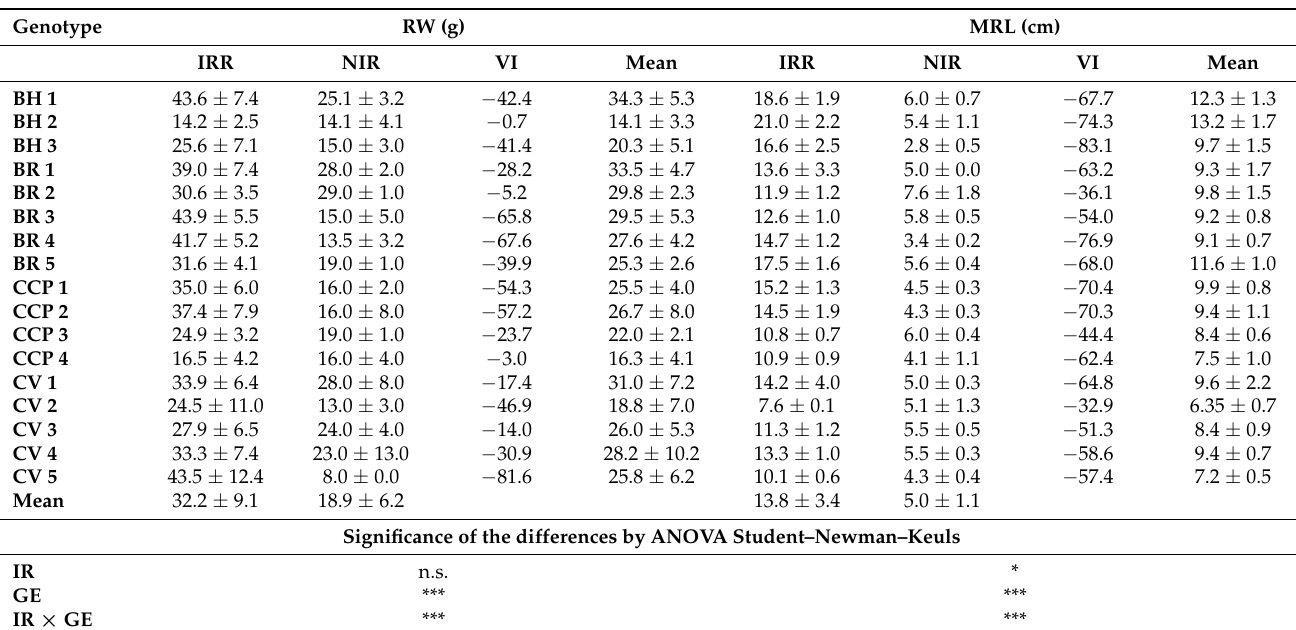
Table 3. Variation in root weight (RW), main root length (MRL), and the variation index (VI) in relation to the experimental factors studied.